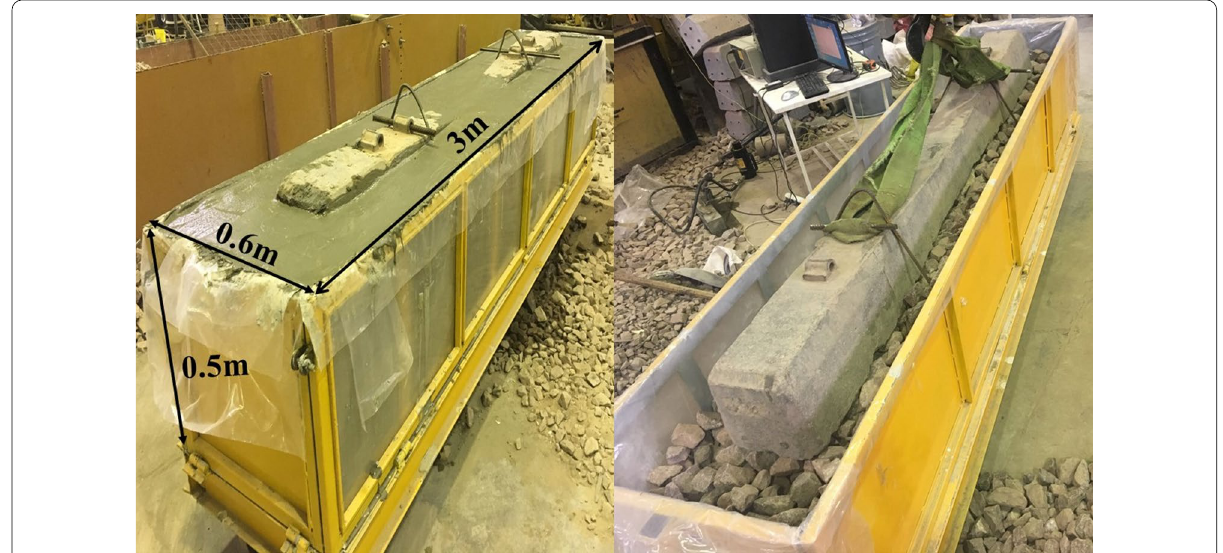
Fig. 5 Casting of PAC beam before and after mortar injection: (Right) before injection, (Left) after